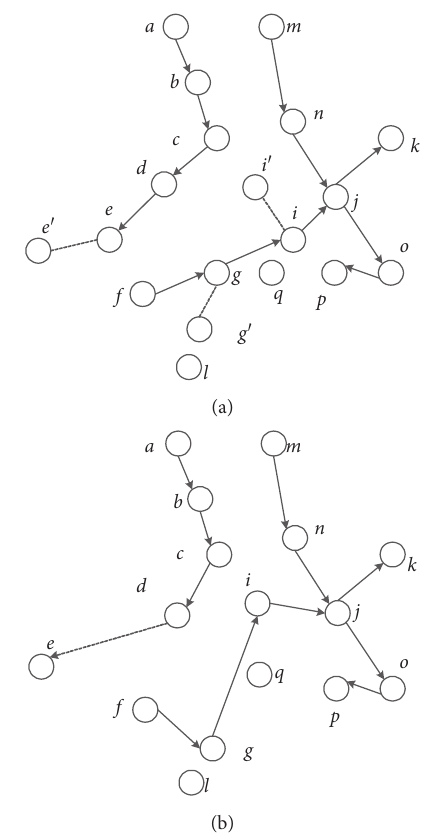
Figure 7: Sensor node dynamic network. (a) t � t